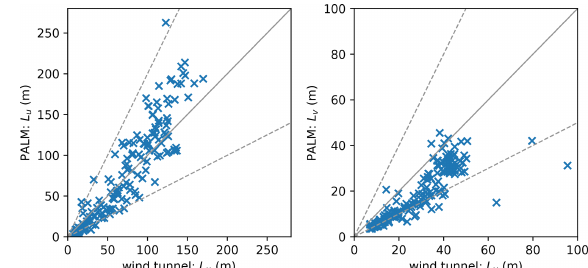
Figure 12. Scatter plots of wind tunnel and PALM measurements of the length scales L u and L v of the velocity components u and v , re- spectively, for all 25 measurement stations and all heights (173 data pairs in total). Solid lines indicate perfect agreement and dashed lines indicate the area between a deviation factor of 0.5 and